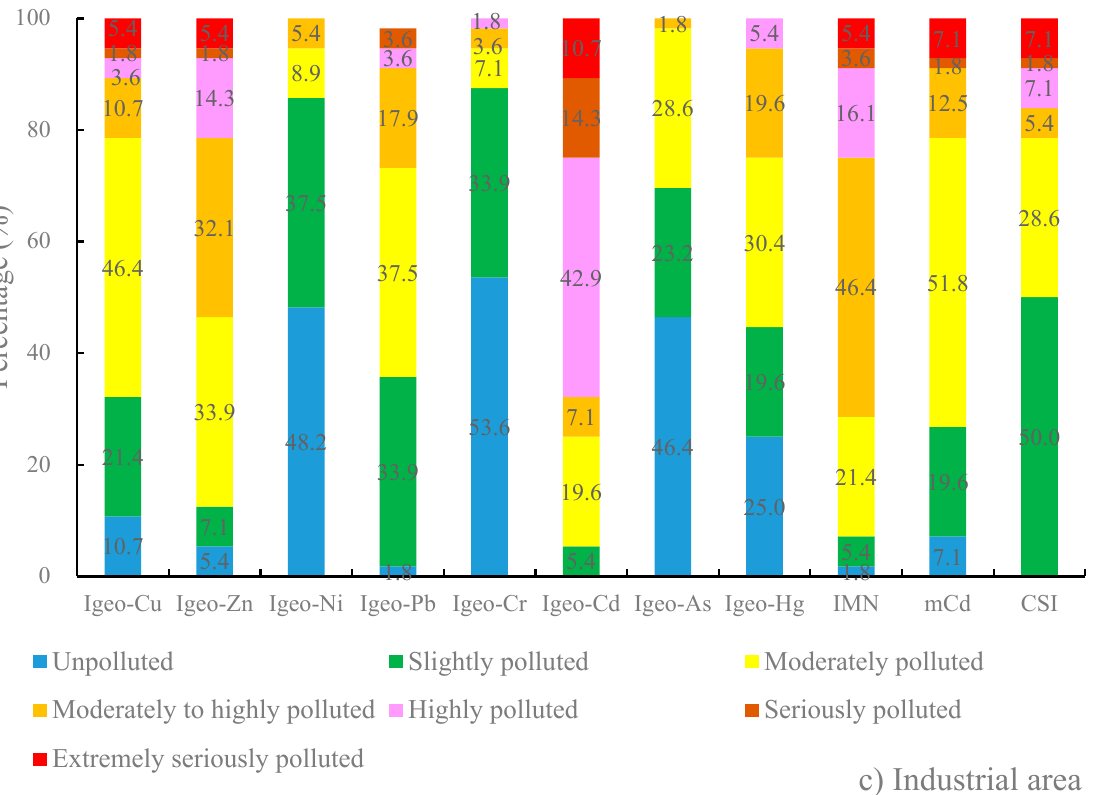
Figure 2. Percentage composition of different pollution degree based on calculation results of I geo for every element and I MN , mC d , and CSI for eight heavy metals ( a ) city parks, ( b ) landfill, and ( c ) industrial area.